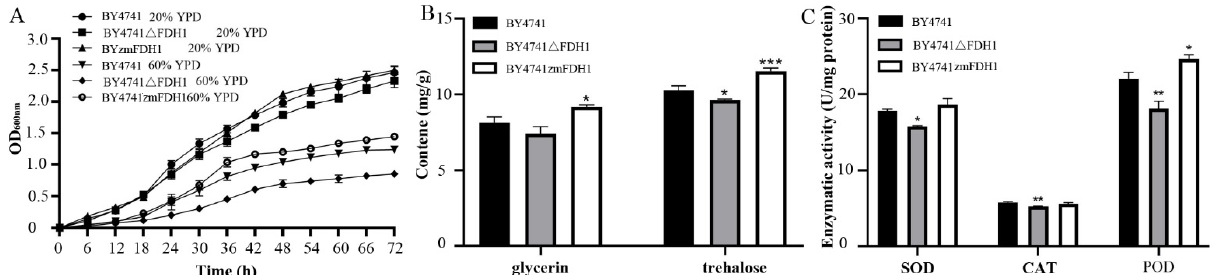
Figure 2. The influence of sugar stress on the growth of BY4741, BY4741 △ scFDH1 and BY4717zmFDH1. ( A ): The OD600 values of BY4741, BY4741 △ scFDH1 and BY4717zmFDH1. ( B ): The intracellular glycerol and trehalose contents of BY4741, BY4741 △ scFDH1 and BY4717zmFDH1 un- der 60% YPD. ( C ): The enzyme activities of CAT, SOD and POD of BY4741, BY4741 △ scFDH1 and BY4717zmFDH1 under 60% YPD. ( A ): Two-way analysis of variance (ANOVA) ; ( B , C ): one-way analysis of variance (ANOVA) followed by Tukey test. * represents significant difference, p value < 0.05, ** represents extremely significant difference between treatment and control, p value < 0.01, and *** represents extremely significant difference between treatment and control, p value < 0.001.